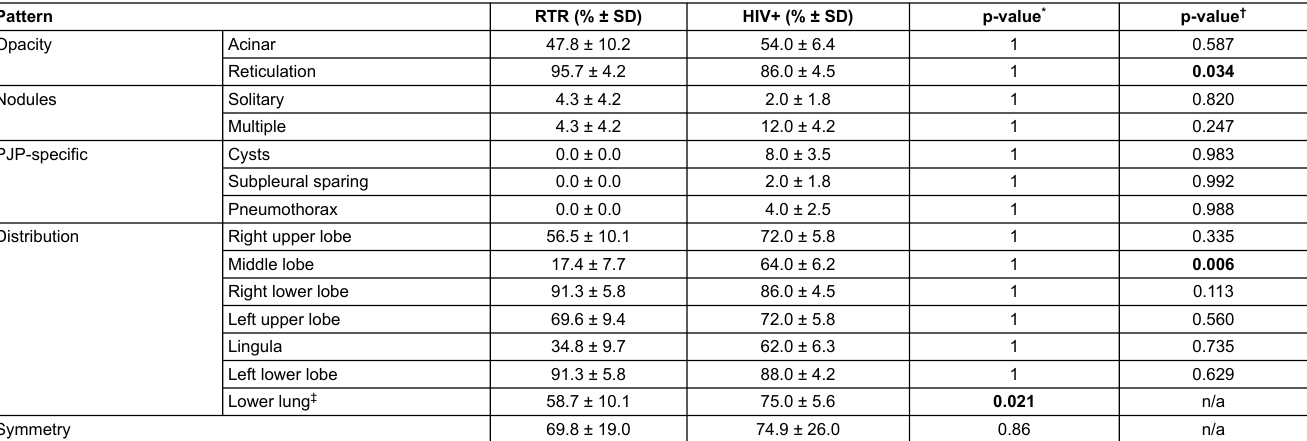
Table 3: Pneumocystis jirovecii pneumonia patterns on chest